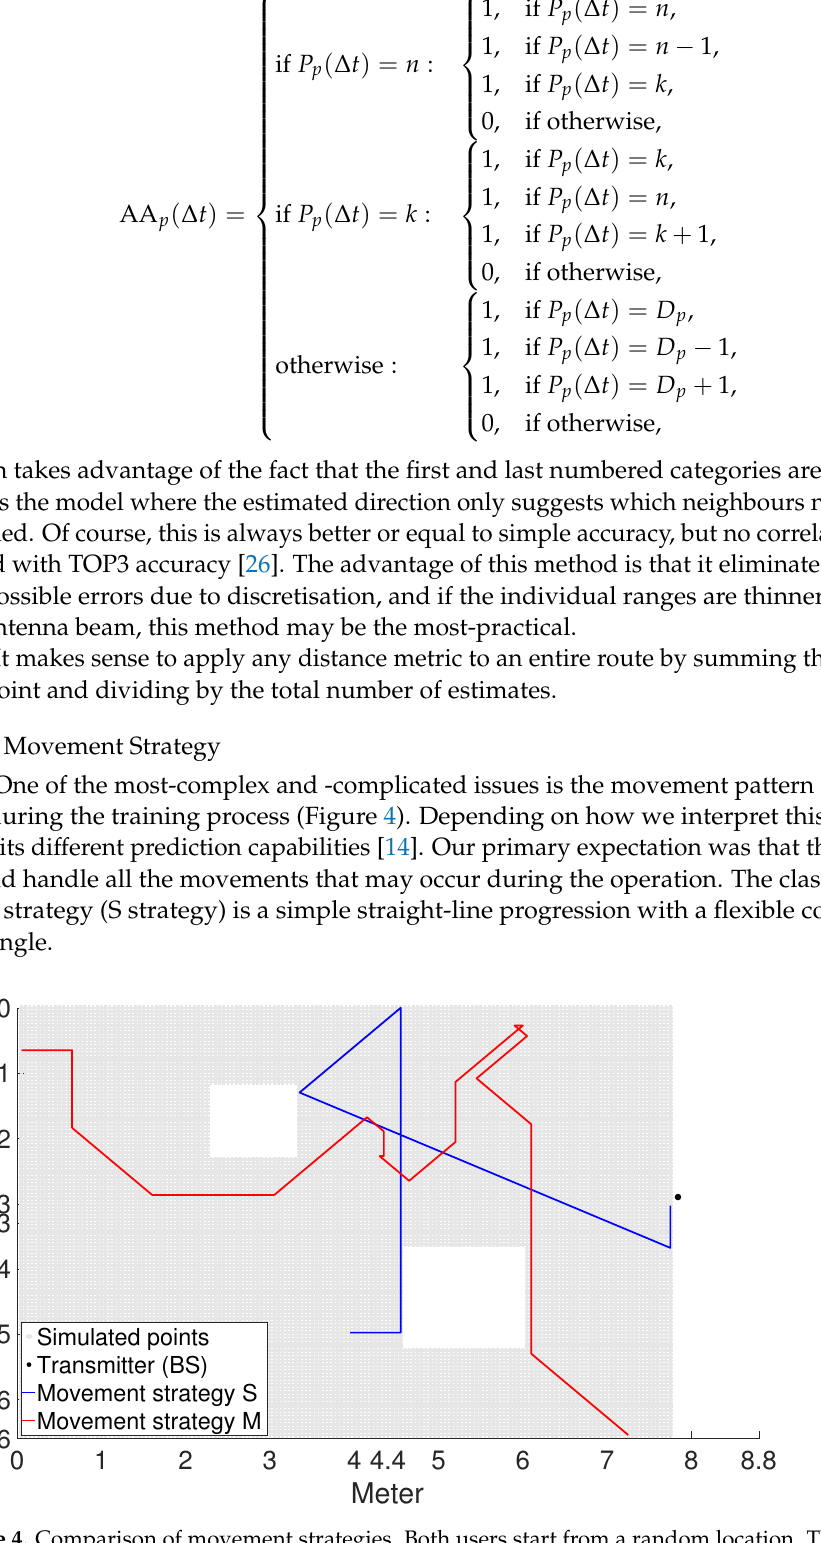
Figure 4. Comparison of movement strategies. Both users start from a random location. Their speed is the same, 5 cm/step. In the case of the Markov method, a behavioural profile that promotes frequent straight-line movement was suitable